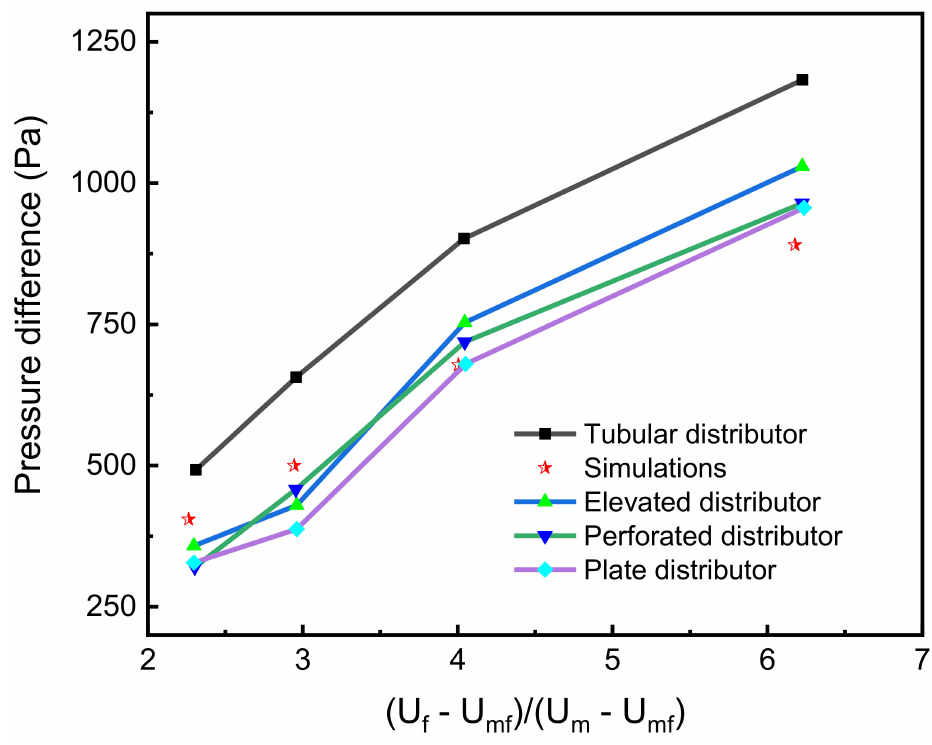
Figure 8. Influence of gas distributor design on temperature profiles. Adopted from Rahimpour et al.